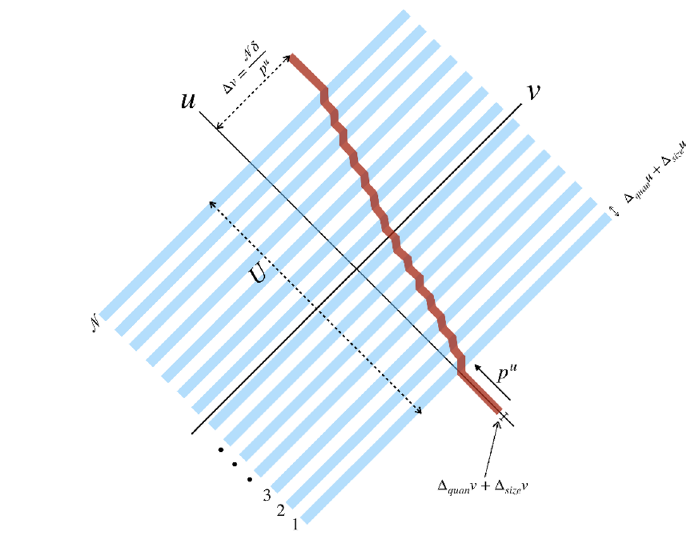
Figure 15 . Total time delay for a coherent state of incoming G J particles after crossing N indepen- dent shockwaves sourced by another particle ( G